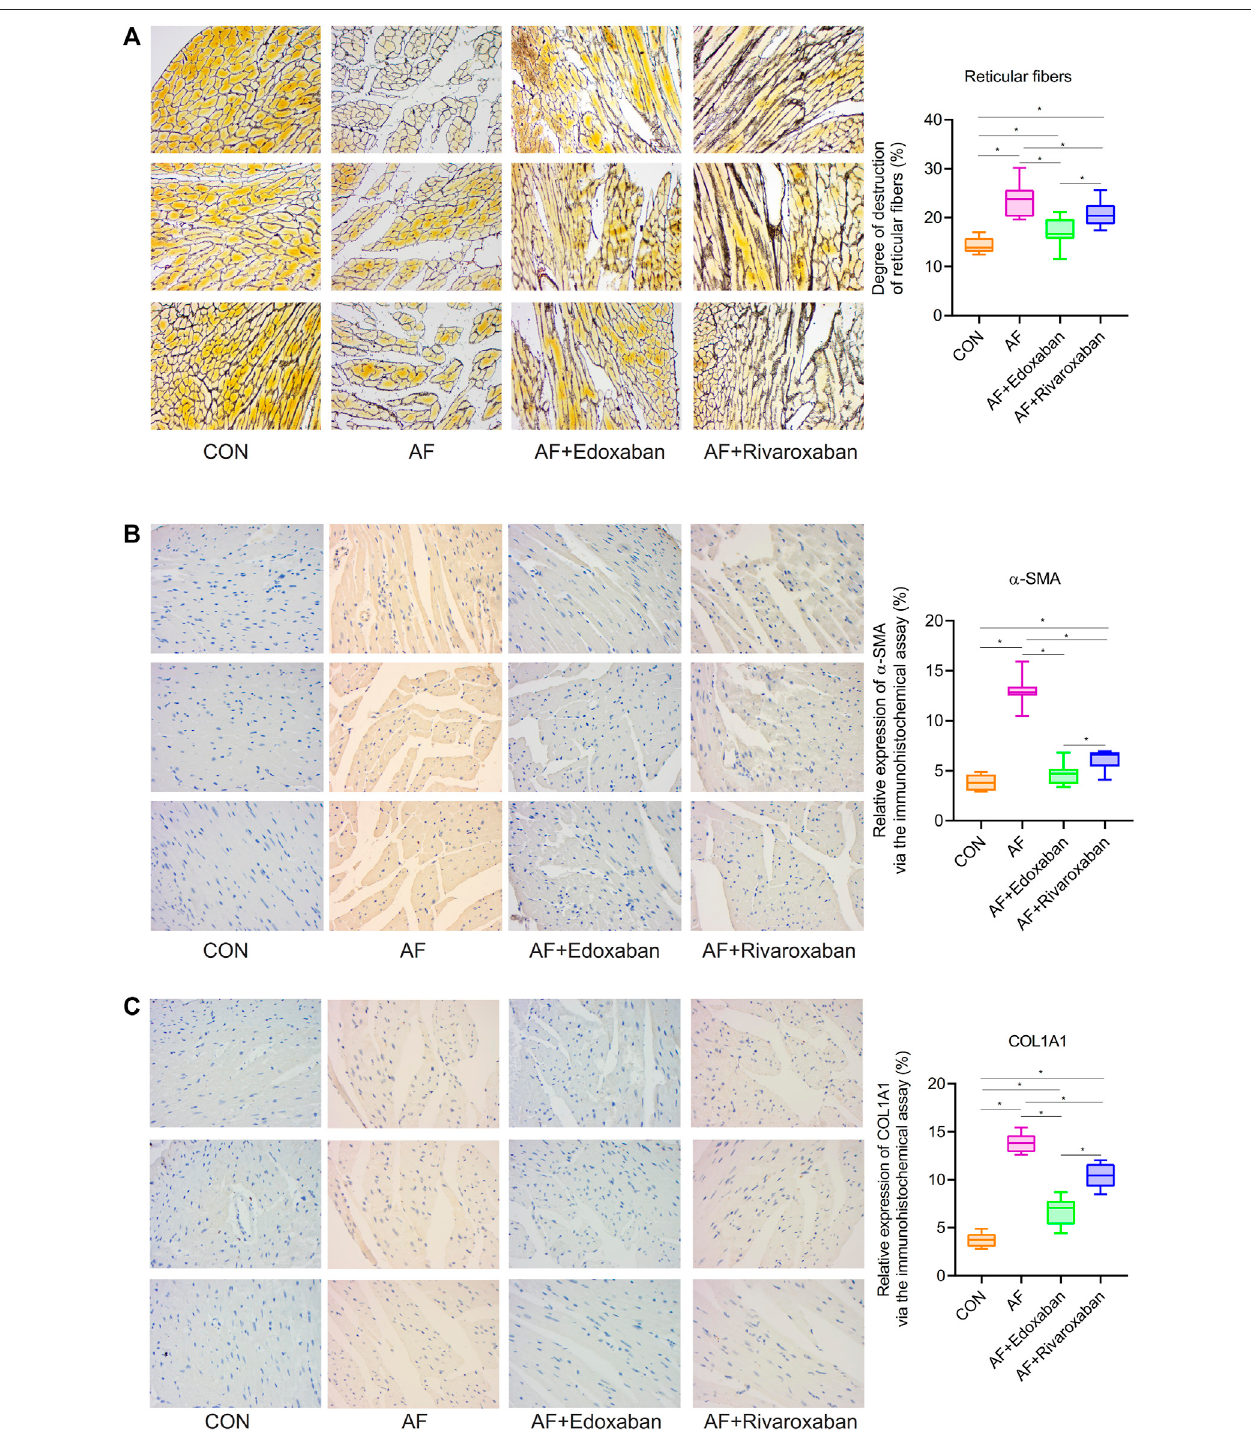
FIGURE 4 | Lower degree of destruction of reticular fi bers in the AF + edoxaban group and expressions of α -SMA and COL1A1 in the AF mice. (A) Degree of destruction of reticular fi bers in the AF + edoxaban group or the AF + rivaroxaban group was lower than the AF group. After using edoxaban or rivaroxaban, the expressions of (B) α -SMA and (C) COL1A1 were signi fi cantly decreased via the immunohistochemistry assay ( p < 0.05).